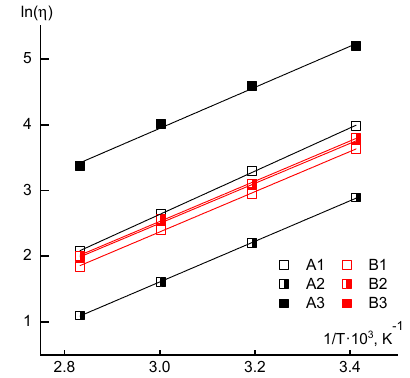
Figure 10. Temperature dependences of the Newtonian viscosity in the coordinates of the Arrhenius